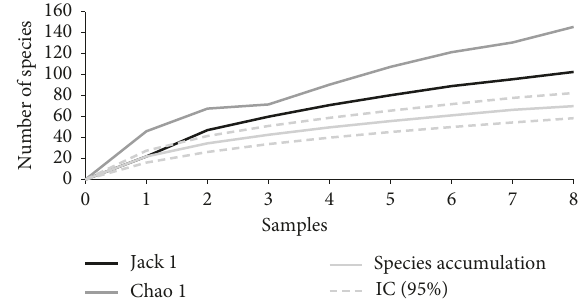
Figure 4: Nonparametric richness estimators (Chao 1 and Jack- knife 1) and species accumulation curve (collector’s curve) for bees in Carutapera, MA, between August 2013 and December